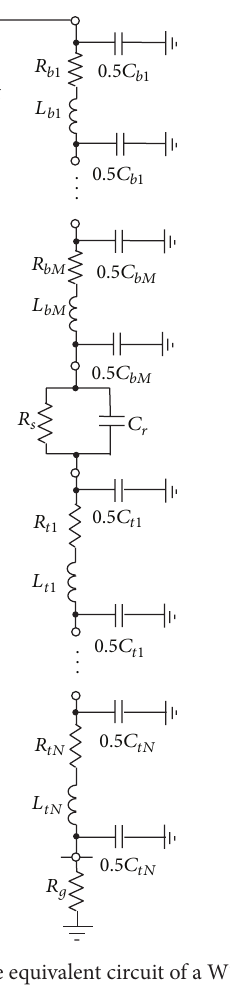
Figure 6: Complete equivalent circuit of a WT.